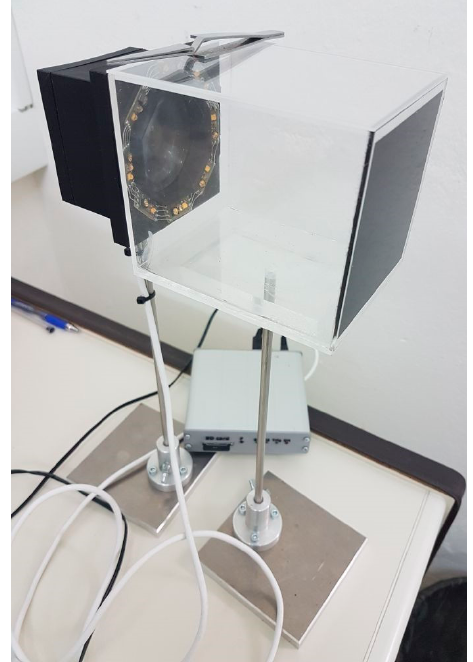
Figure 6. The three ways to use the suggested sensor and its associated recorder: by tethering an insect inside the probe volume of the sensor (e.g., by holding its legs with an inverted tweezer), by confining the insect in a transparent cage that is large enough to allow the insect to fly, or by inserting the sensor in an insectary cage containing a free-flying insect. Notice the black termination plane on the right of the Plexiglas (MAXiBLACK, Advanced Coating Products, Acktar Store LTD, Kiryat-Gat, Israel).